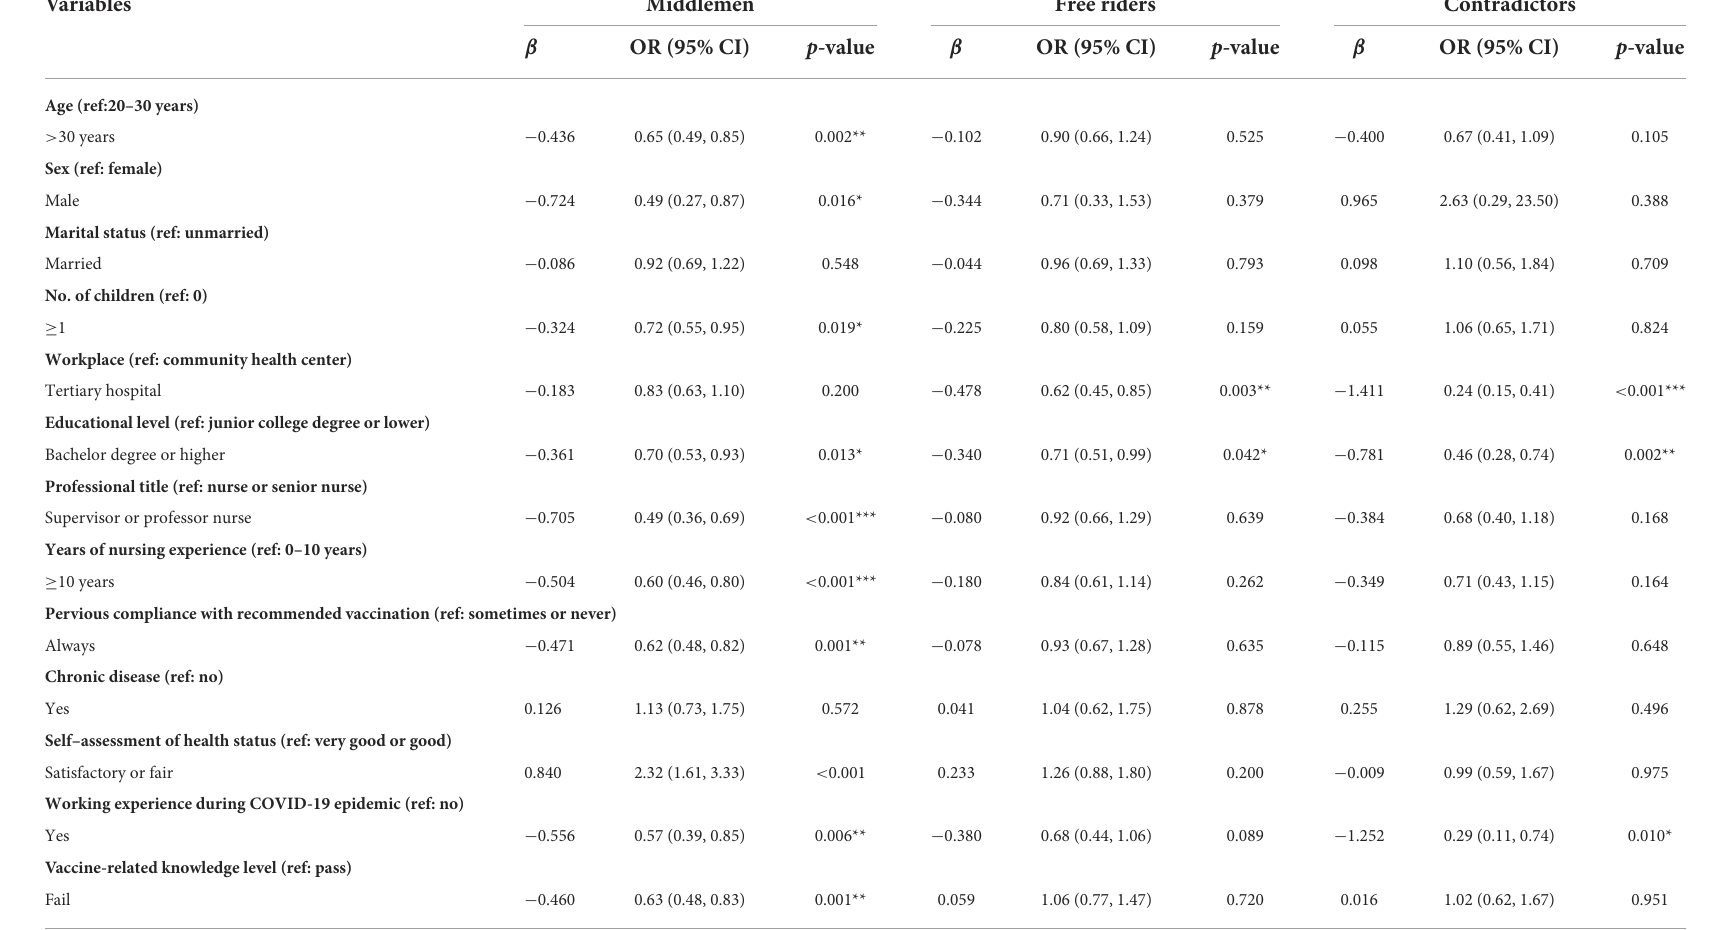
TABLE 5 Predicting pattern membership from individual